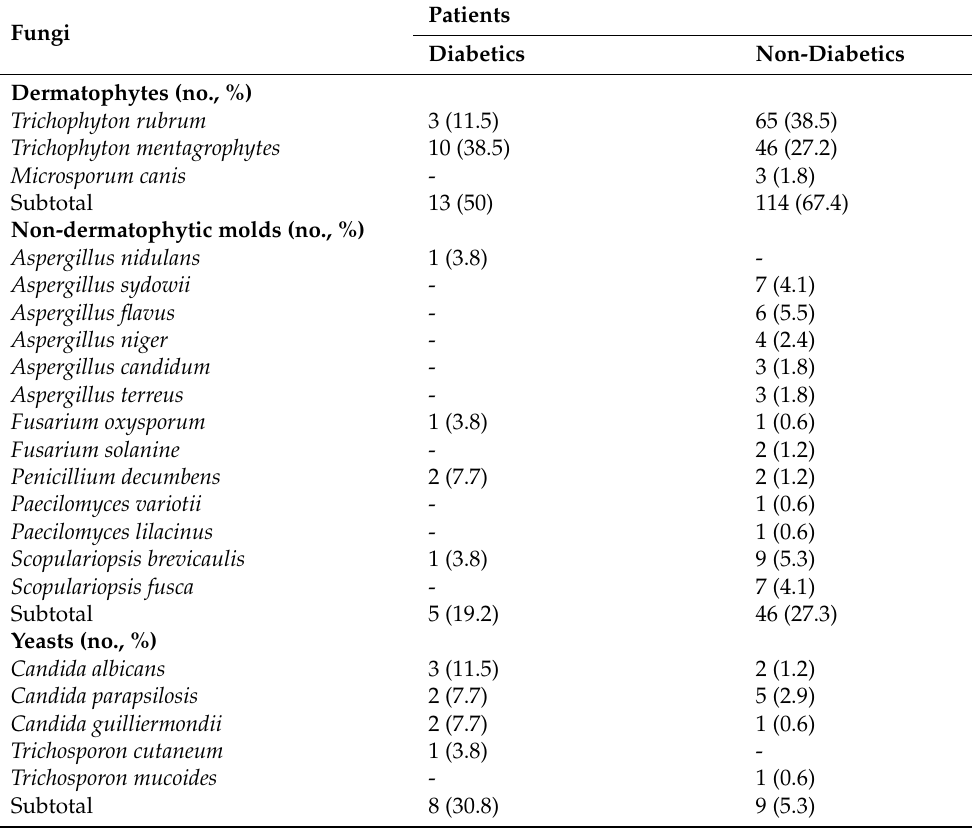
Table 4. Different isolated species in diabetic and non-diabetic